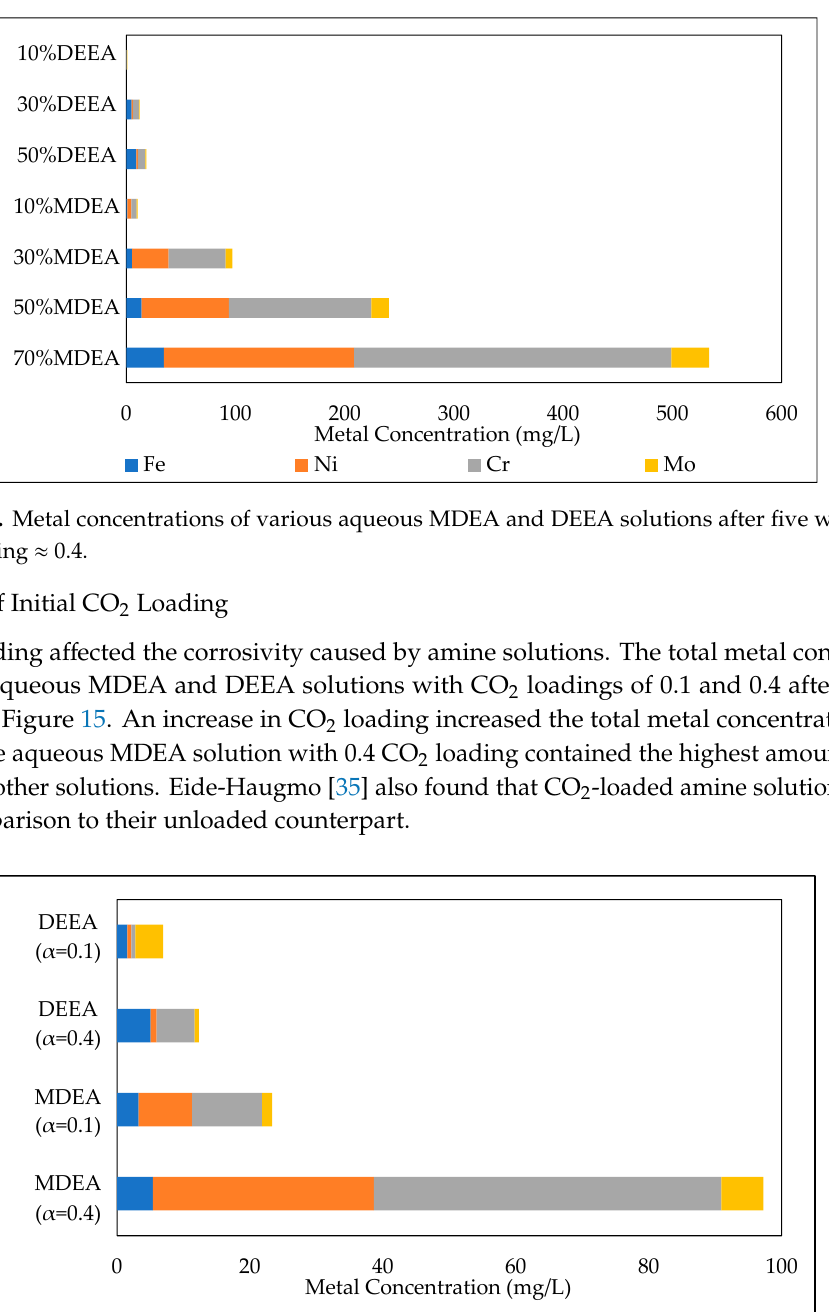
Figure 13. Metal concentrations of amine solutions after five weeks; unloaded amine wt.% = 30; CO 2 loading ≈ 0.1.